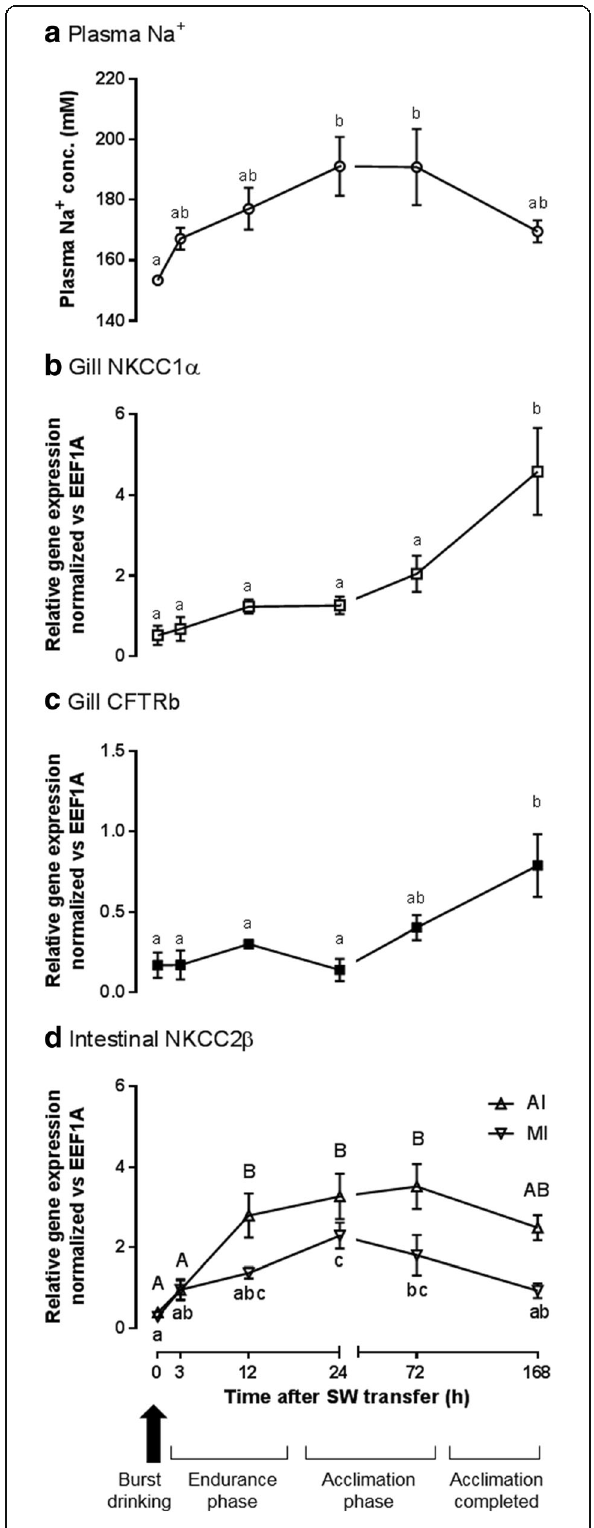
Fig. 1 Effects of time-course freshwater (FW) to seawater (SW) transfer on ( a ) plasma Na + concentration ( N = 6); ( b ) NKCC1 α expression in gill; ( c ) NKCC2 β expression in anterior (AI) and middle (MI) intestine of eels ( N = 5). During initial transfer, eels drink SW copiously (arrow) and ex- pose the gill to SW. Plasma Na + was not increased suddenly (endur- ance phase), subsequently increased during the acclimation period, and gradually established to a new baseline of lower level after SW 7 d (acclimation completed). Similar delayed transient increase was found among NKCC2 β expression in the intestines while branchial NKCC1 α and CFTRb expression increased significantly after SW 7